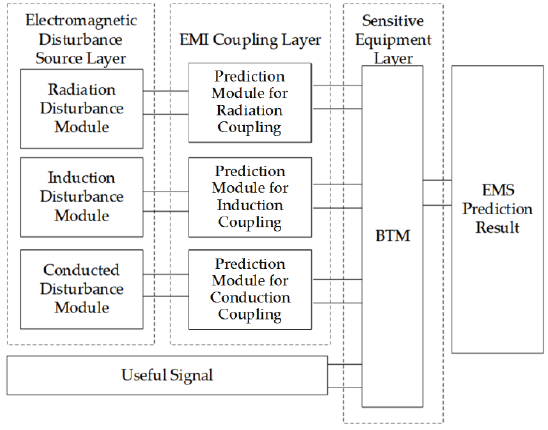
Figure 3. Modular System-level Model.